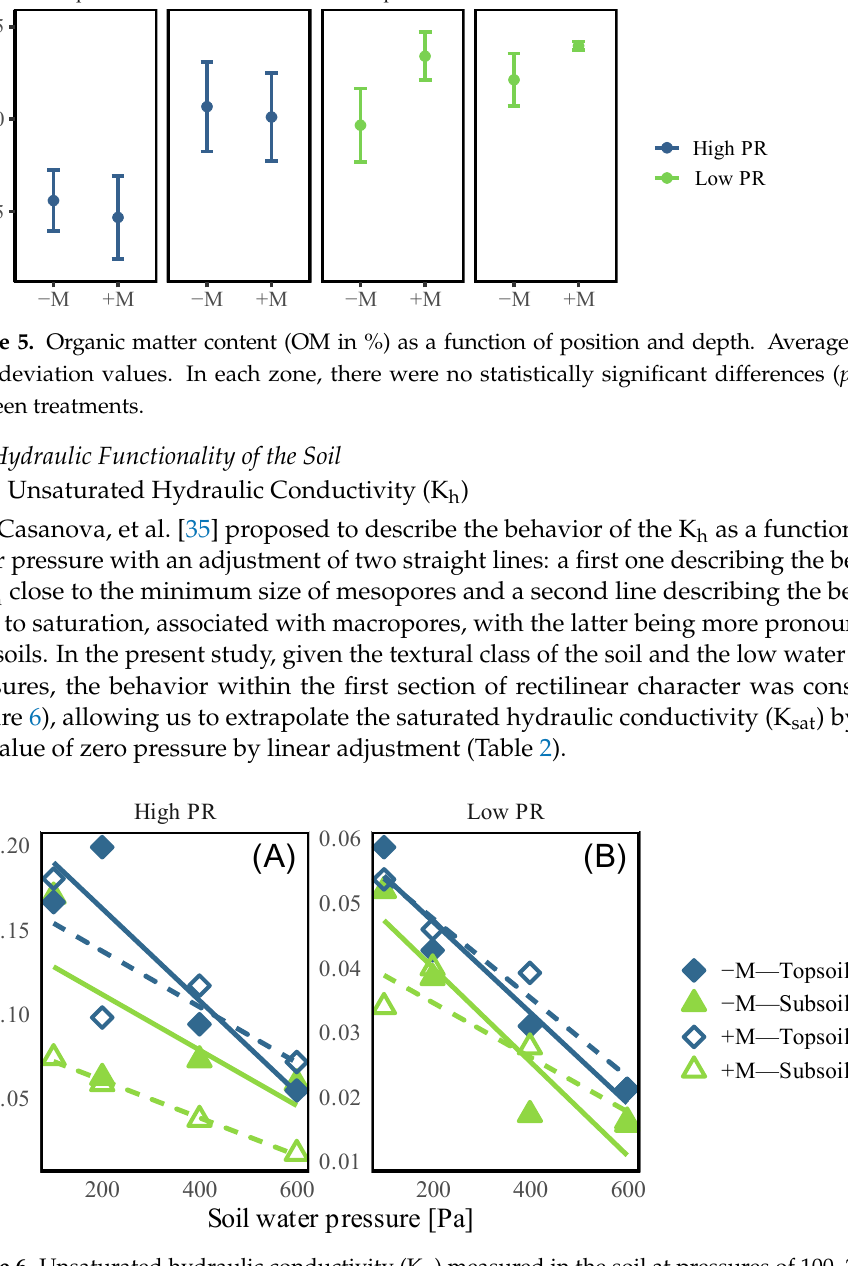
Figure 6. Unsaturated hydraulic conductivity (K h ) measured in the soil at pressures of 100, 200, 400, and 600 Pa. ( A ) High-PR area and ( B ) low-PR zone. The legend applies to both figures. Note the scale change of the y -axis.